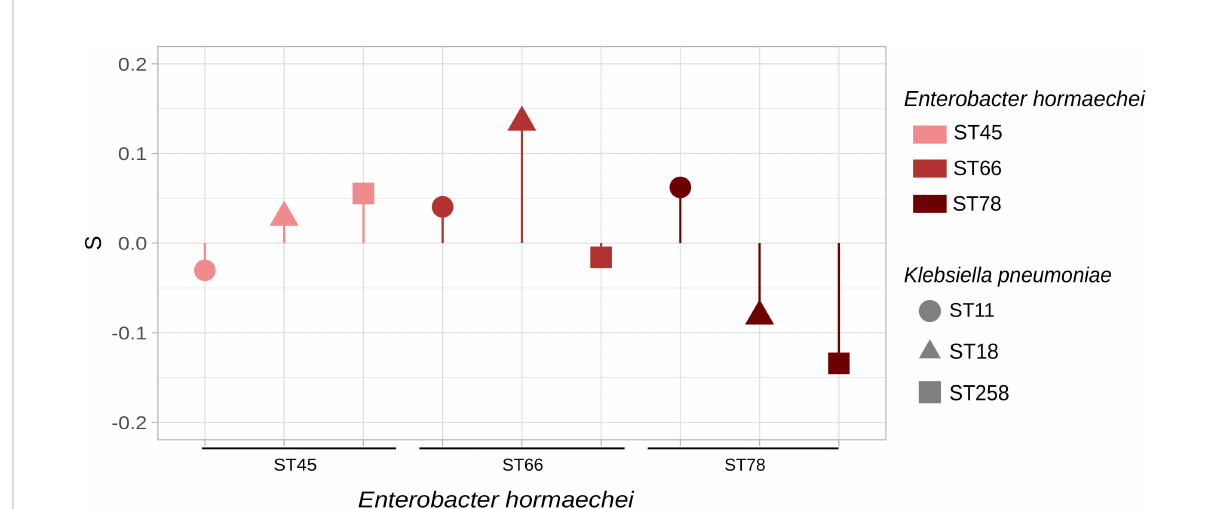
FIGURE 3 Plasmid pDCCK1-KPC from E. hormaechei HA2pEho and K. pneumoniae HA7pKpn strains and genetic platform of bla KPC-2 . Alignment of the novel plasmid pDCCK1-KPC against pIP69 (MN626603.1) and pECL189-1 (CP047966.1). The fi gure was made using